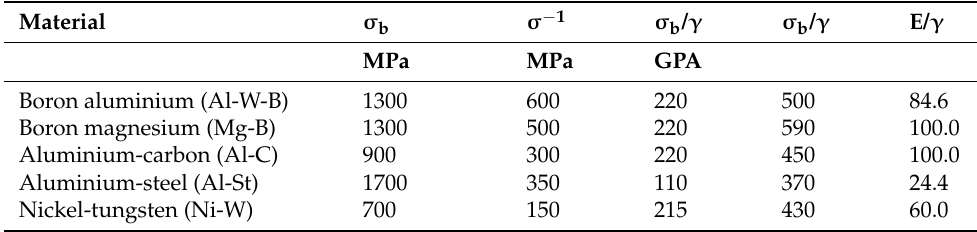
Table 1. Mechanical properties of metal-based composites